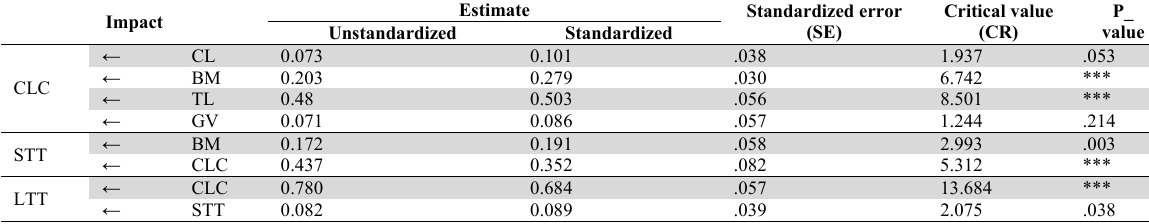
Estimate Standardized error